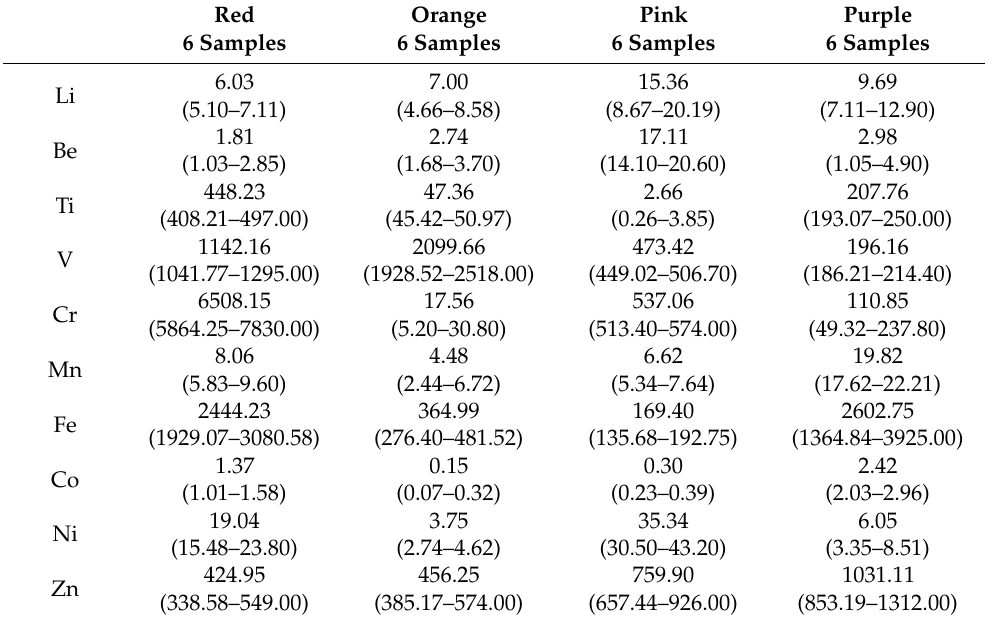
Table 3. Trace element concentrations (ppm) of spinel samples from Mogok by LA-ICP-MS (average and